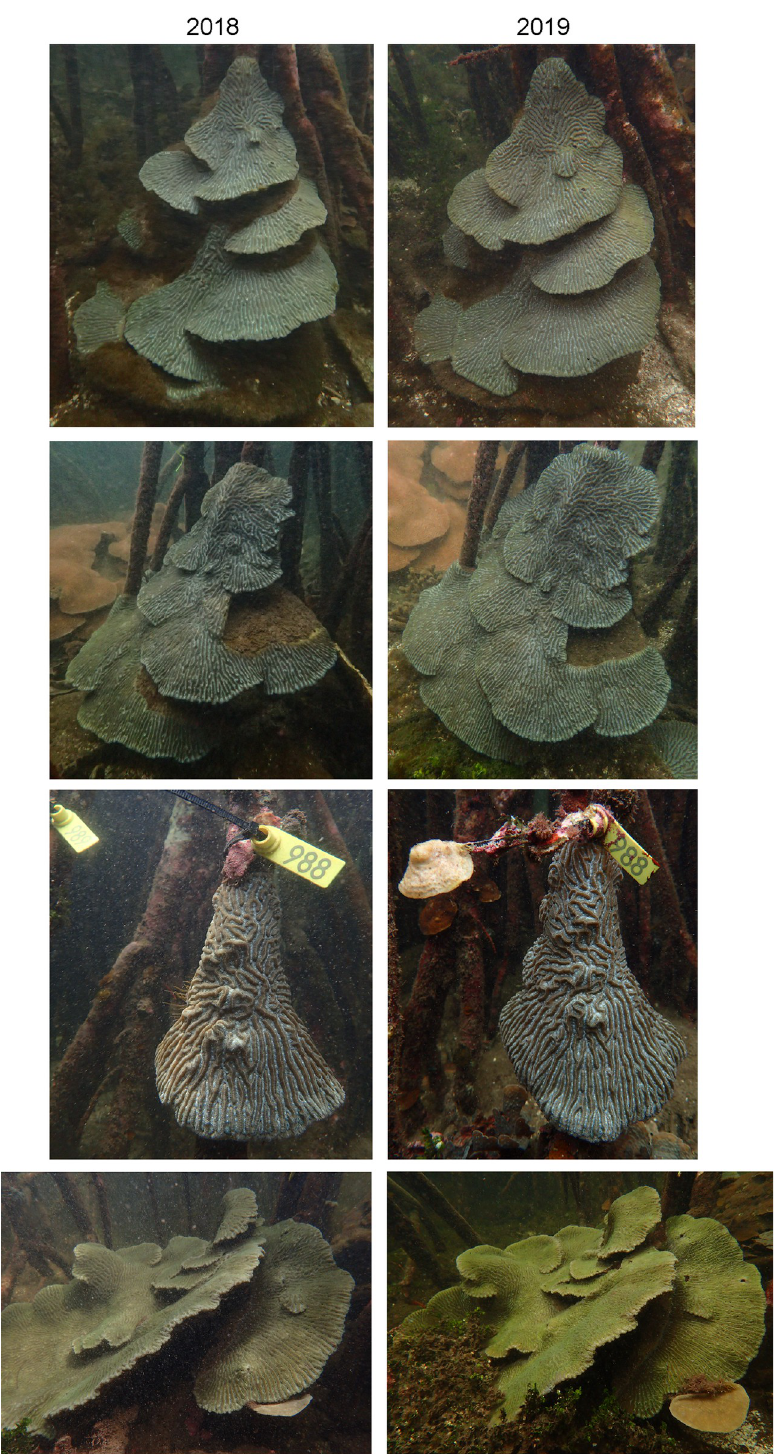
Fig 2. Coral colonies monitored for growth from June 2018 to September 2019. Photographs of four of the monitored coral colonies with year 1 on the left and year 2 on the right, showing how Pseudodiploria colonies had the capacity to regenerate plates after